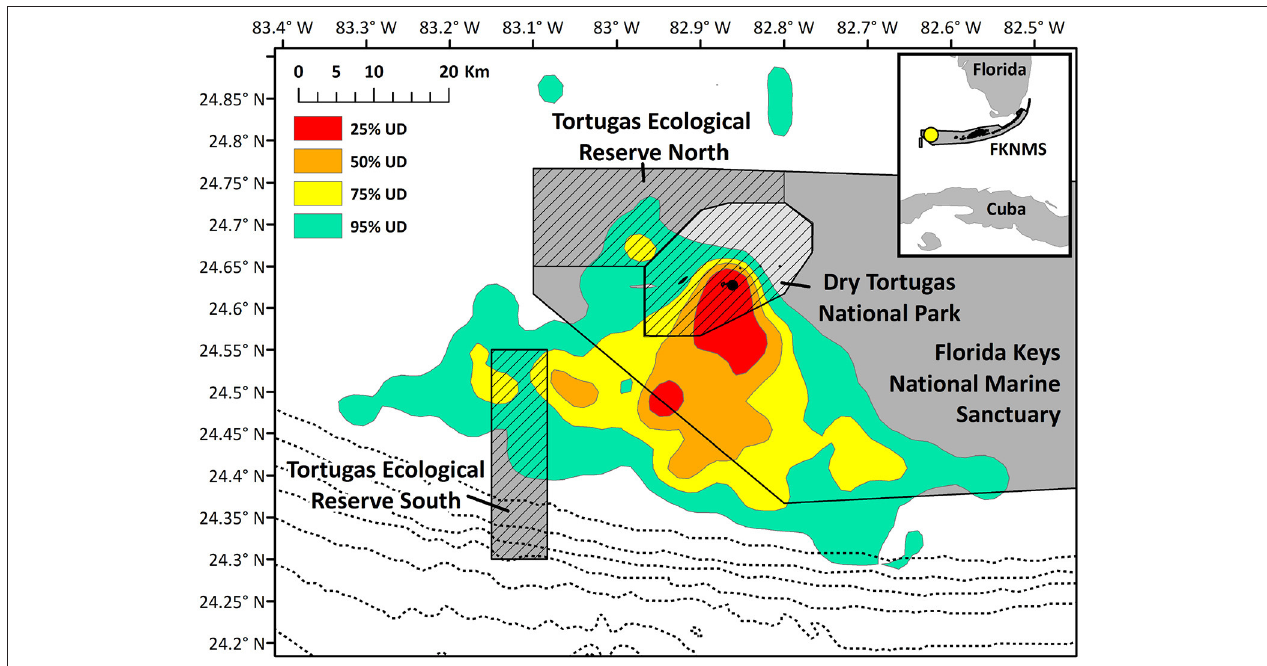
FIGURE 7 | Kernel density home range of all noddy tracks. Hashed areas indicate no-take areas (Dry Tortugas National Park and the two Ecological Reserves), and the dotted line closest to the park indicates the 100m contour, and depth contours grow deeper by 100m moving east to west. The black point indicates the nesting colony on Bush